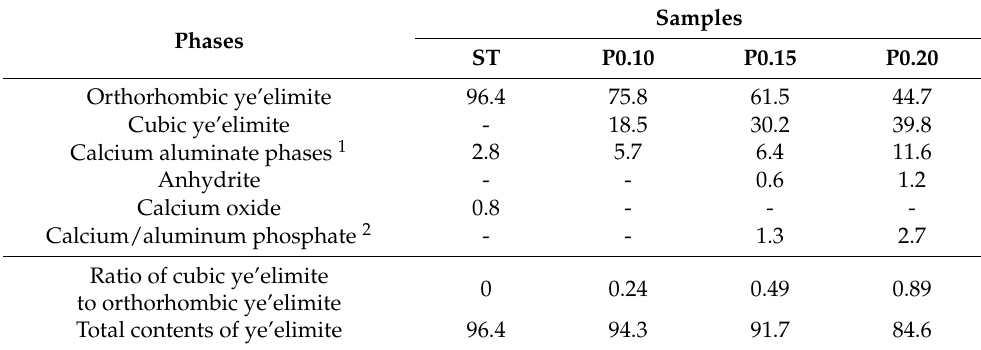
Table 3. RQPA results (wt.%) for clinkers containing P- doped ye’elimite.